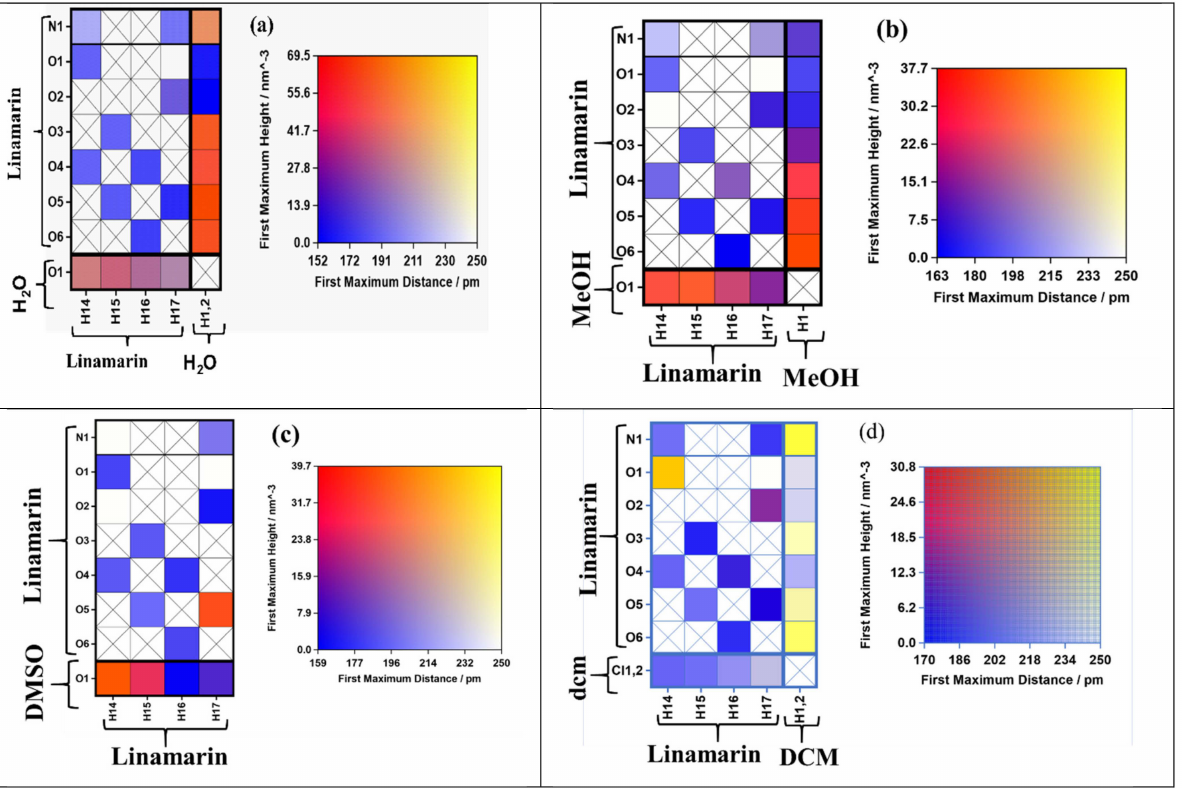
Figure 3. The connection matrix analysis of linamarin in ( a ) water ( b ) Methanol (MeOH), ( c ) Dimethyl sulfoxide (DMSO) and ( d ) Dichloromethane (DCM). The columns correspond to hydrogen bond donors, and rows stand for hydrogen bond acceptors. The square boxes are filled with colours representing the intensity and distance of the maximum solvation shell of radial distribution function